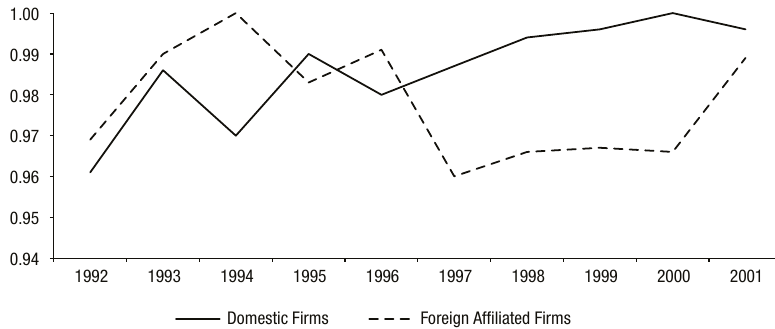
Fig. 2. Technology Gap Ratios of Domestic and Foreign Affiliated Firms